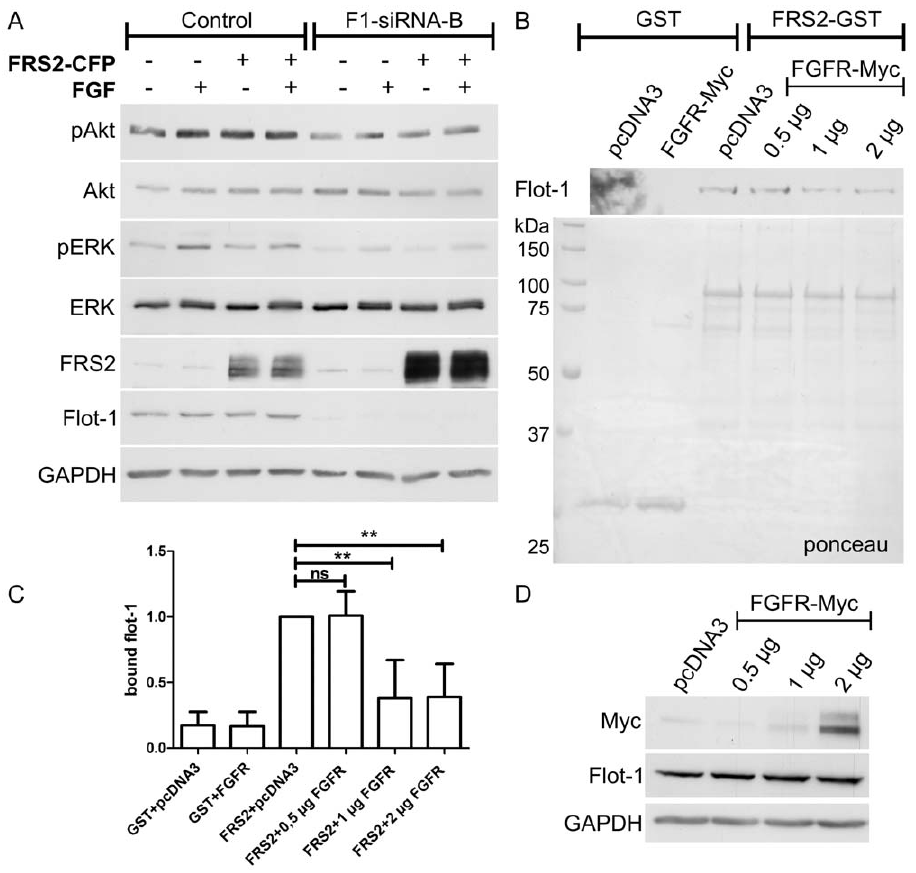
Figure 3. Overexpression of FRS2 does not compensate for the signaling defects in flot-1 knockdown cells. FGF receptor and flot-1 compete for the binding to FRS2. (A) Flot-1 was knocked down in HeLa cells by means of siRNAs and the cells were transfected with FRS2-CFP. Starved cells were stimulated with FGF for 5 min, and the activation of Akt (uppermost blot) and ERK2 (3 rd blot) was measured with phospho-specific antibodies. The third blot from the bottom shows the analysis of the transfection efficiency of FRS2-CFP and of the 2 nd one the knockdown efficiency of flot-1. Lowermost blot (GAPDH) shows equal protein loading. (B) Purified FRS2-GST was immobilized on sepharose and incubated with lysates of HeLa cells transfected with increasing amounts of FGFR-myc (0.5 to 2 m g). The binding of endogenous flot-1 from these lysates was tested (upper blot). (C) Quantification of the flot-1 bound to FRS2. In the presence of increasing amounts of FGFR, the binding is significantly reduced. (D) Expression of FGFR was verified by Western